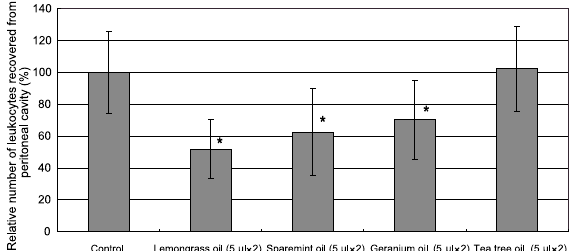
FIG. 1. Effect of essential oils on casein-induced leukocyte recruitment. Essential oils were injected into mice 2 and 4 h after casein induction. After 6 h, leukocytes in the peritoneal cavity were collected and their numbers were counted. Each value represents an average of four to eight samples and the standard deviation. * p B /